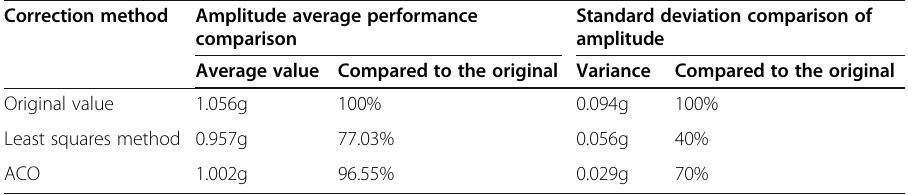
Table 5 Comparison of amplitude before and after correction of acceleration of gravity Correction